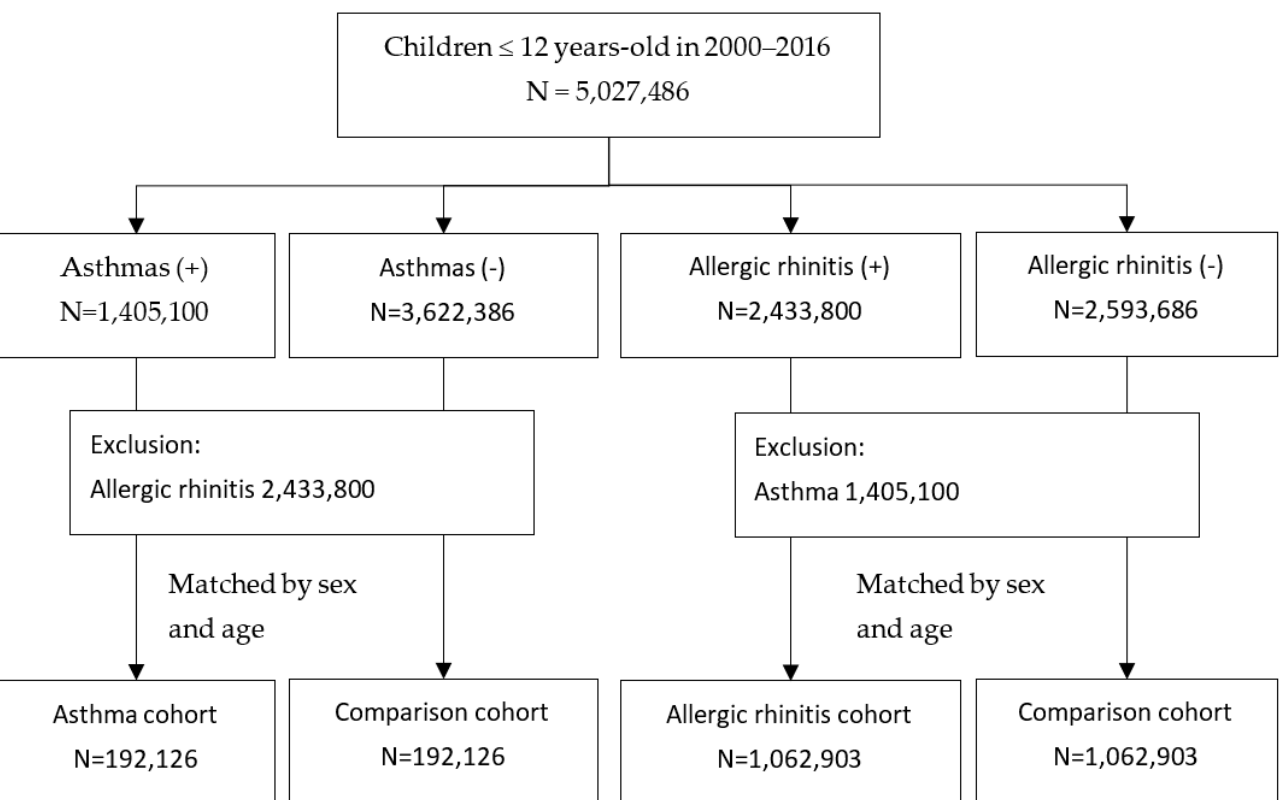
Figure 1. Flow chart for selecting cohorts with and without asthma and cohorts with and without allergic rhinitis from children of ≤ 12 years-old in 2000–2016.